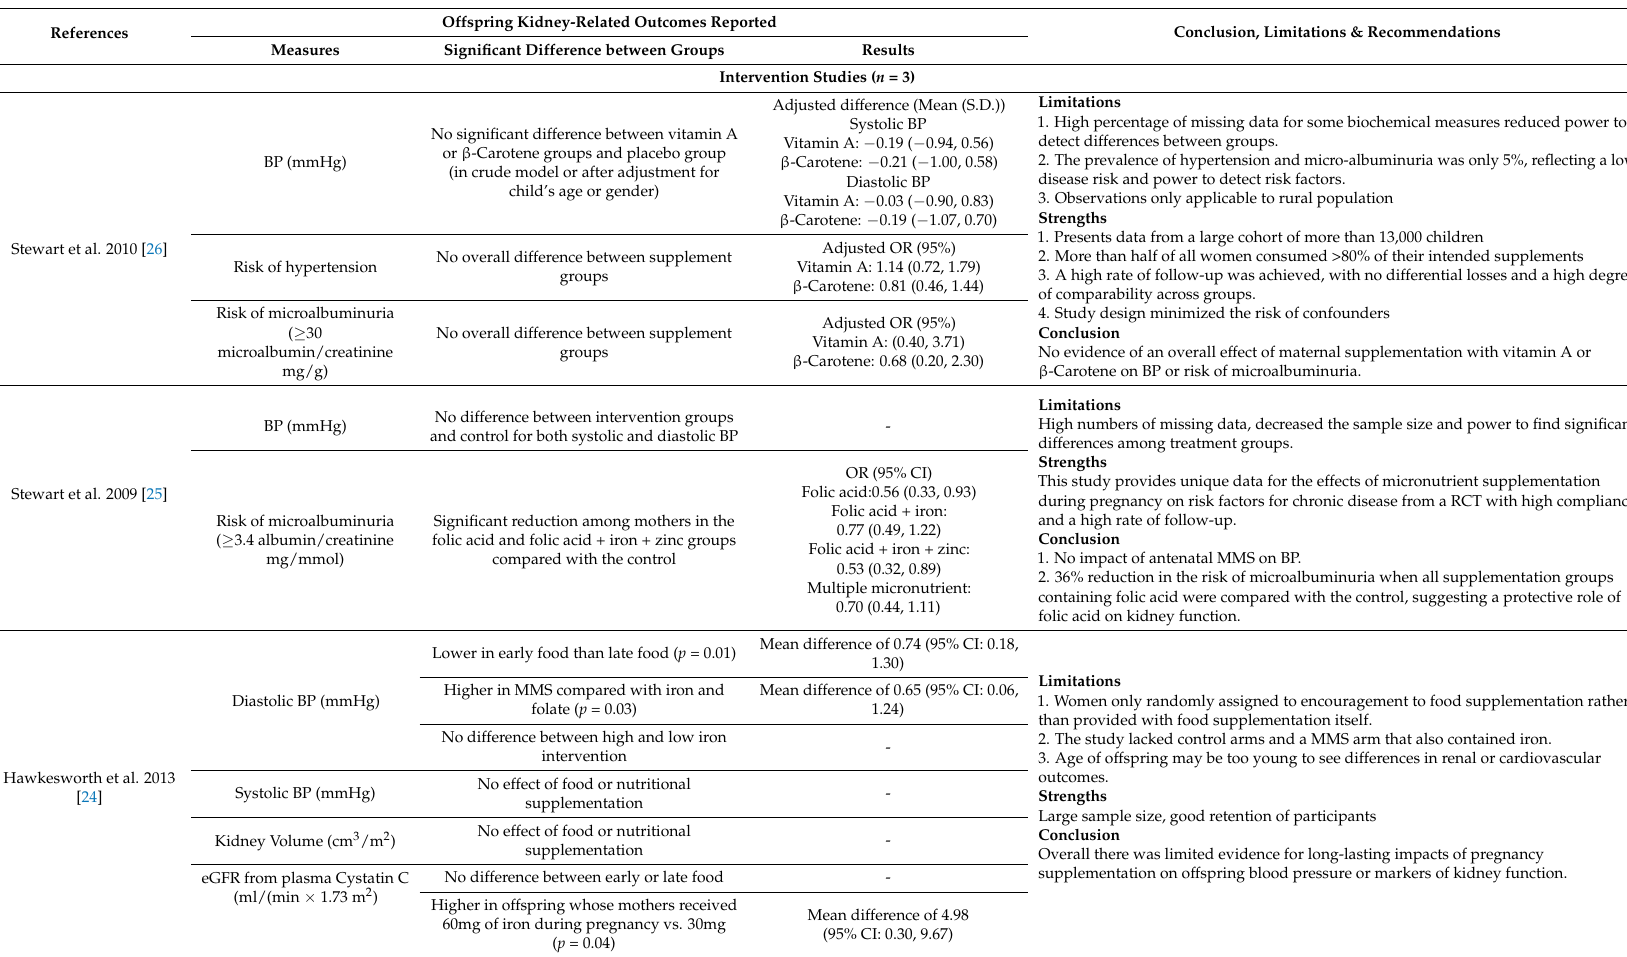
Table 3. Results of intervention